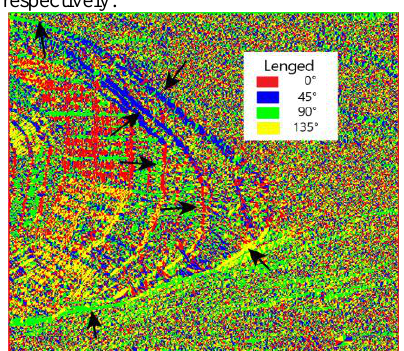
Figure. 5 At the point of the arrow, the gradient direction of the edge pixel represents the edge significantly. These edges include farmland boundaries, roads, artificial dams, vegetation boundaries and